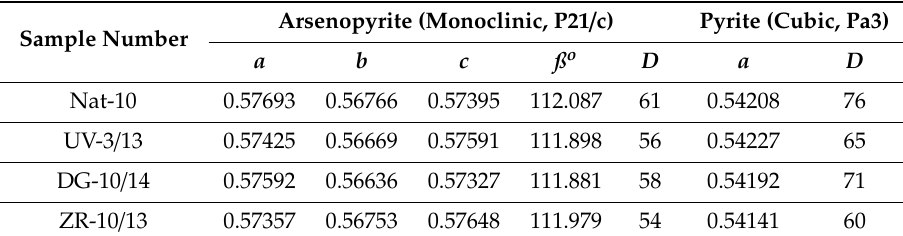
Table 3. Results of the X-ray di ff raction study of arsenopyrite and pyrite crystals.